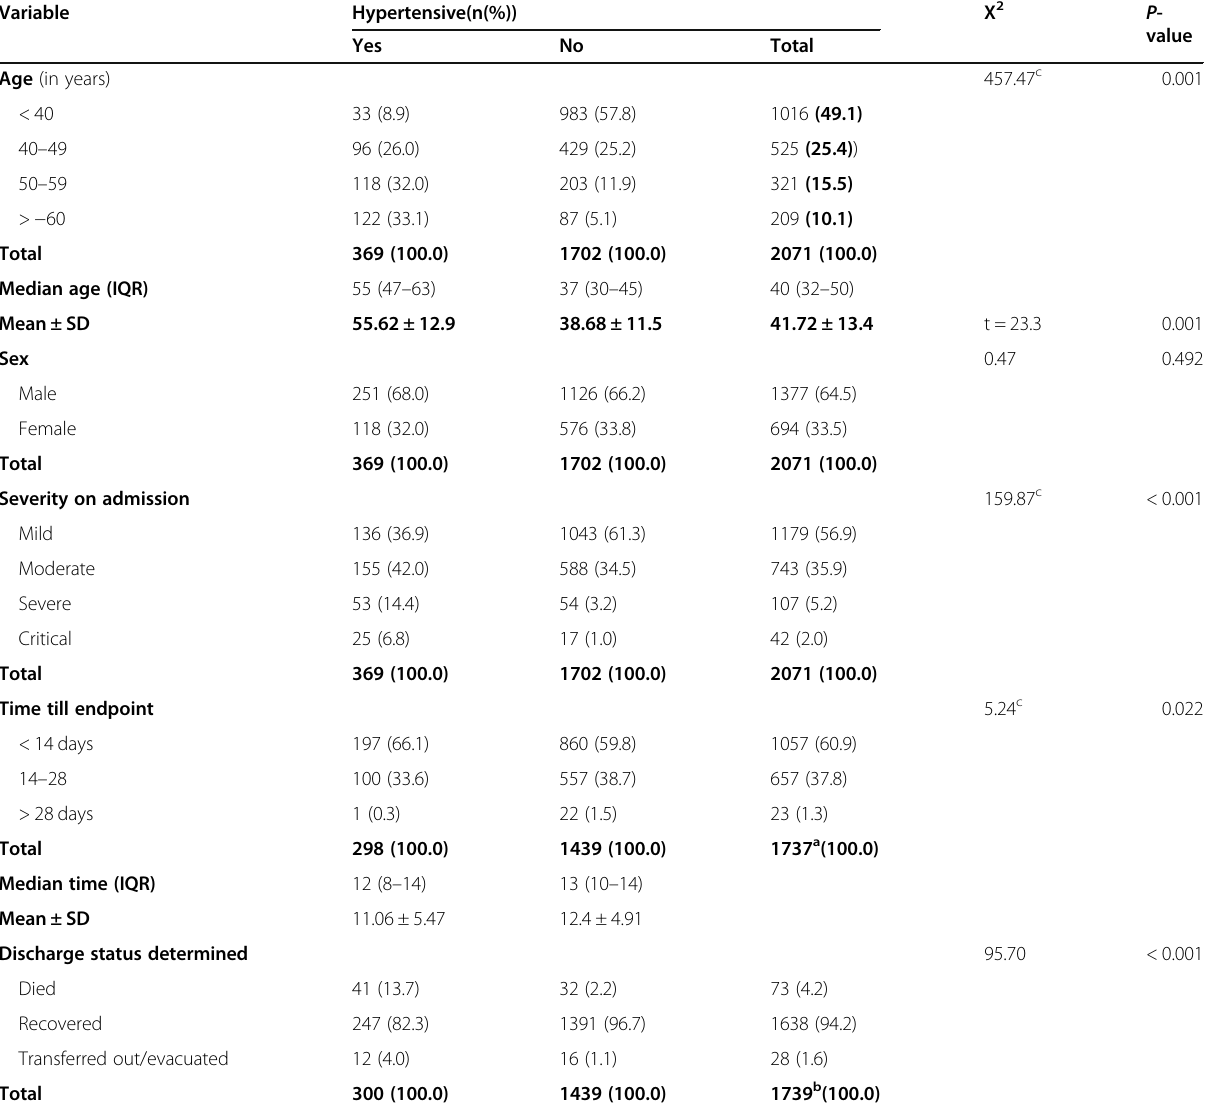
Table 2 Comparison of patients ’ characteristics and morbidity/ mortality against hypertensive status